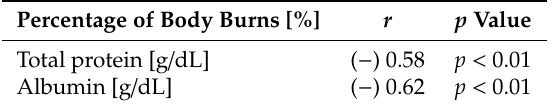
Table 5. Correlation between percentage of body burns and protein